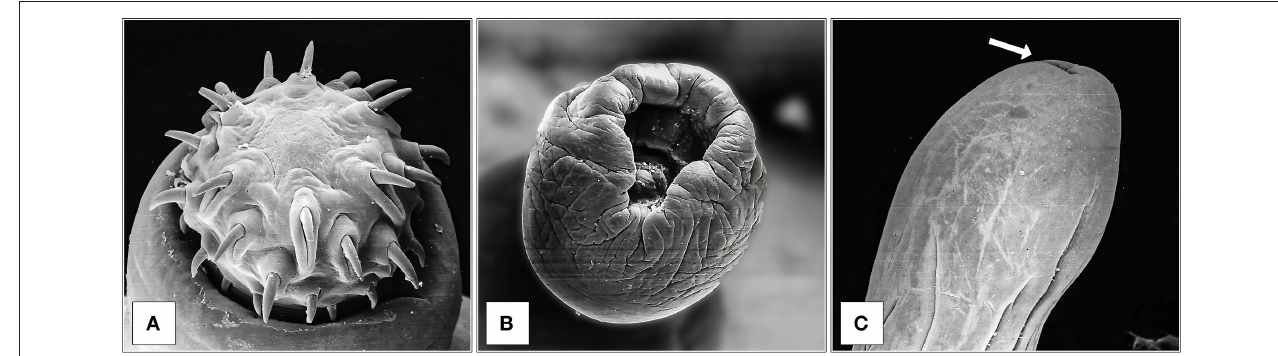
FIGURE 1 | SEM observation of M. hirudinaceus : Cephalic region (A) ; Copulatory bursa of male (B) ; Caudal region of female (C) , and genital pore (arrow).